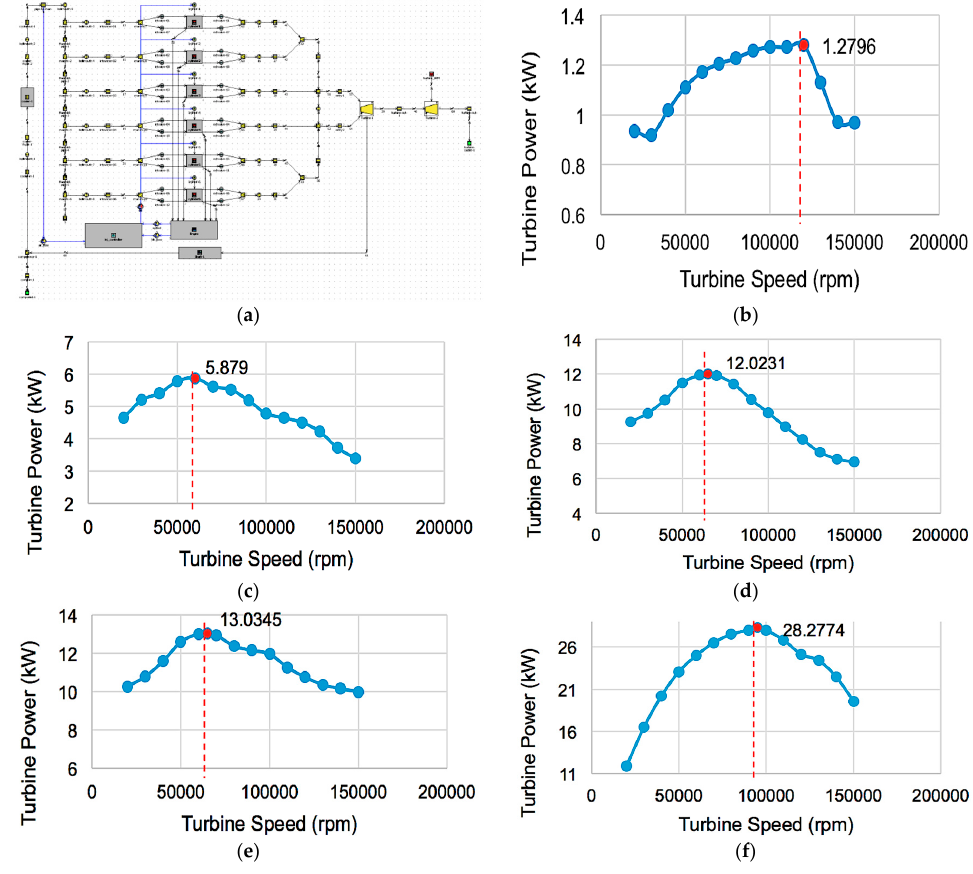
Figure 4. Turbocompounding system application on the engine: ( a ) Schematic view of turbocompounding system modeled in GT-Power code; ( b ) Turbine power generated in turbocompounding system at P1; ( c ) Turbine power generated in turbocompounding system at P2; ( d ) Turbine power generated in turbocompounding system at P3; ( e ) Turbine power generated in turbocompounding system at P4; ( f ) Turbine power generated in turbocompounding system at P5. As explained earlier, to implement a turbocompounding system, an additional turbine is added after the existing turbine in the model to simulate and identify the power that can be generated. However due to the dependency of power to the turbine rpm, it is necessary to identify the optimum rpm wherein the turbine produces maximum power at a particular engine speed. Since, it is not possible to identify the optimum turbine rpms at each individual point, the plot, which was initially used for engine calibration, is performed. Five points P1–P5 are used as benchmarks to set the optimum rpm for simulations. Figure 1a shows the BSFC map denoting the points taken for identifying the optimum rpm. At point P1, simulations were carried out in GT-Power for turbine speeds of 20,000–150,000 rpm and the power from the turbine was noted. The plot for the power with respect to the turbine rpm is given in Figure 4b. It can be seen from the plot that the maximum power of 1.279 kW, is obtained at a turbine rpm of 120,000 rpm. This means that at that particular turbine speed, maximum power can be recovered, but this is only applicable from P1. For other points, similar parametric sweeps are made to identify the optimum rpm as given in Figure 4c to Figure 4f. The results from the above plots are presented in Table 3, which shows the maximum power and the optimum rpm at that point. It also details what rpms are taken for simulations on the basis of the results obtained for the 38 points used for the study. Using these results, simulations are carried out similar to previous simulations on the original engine model to study the BSFC, and the subsequent reduction due to the recovered power from the second turbine.